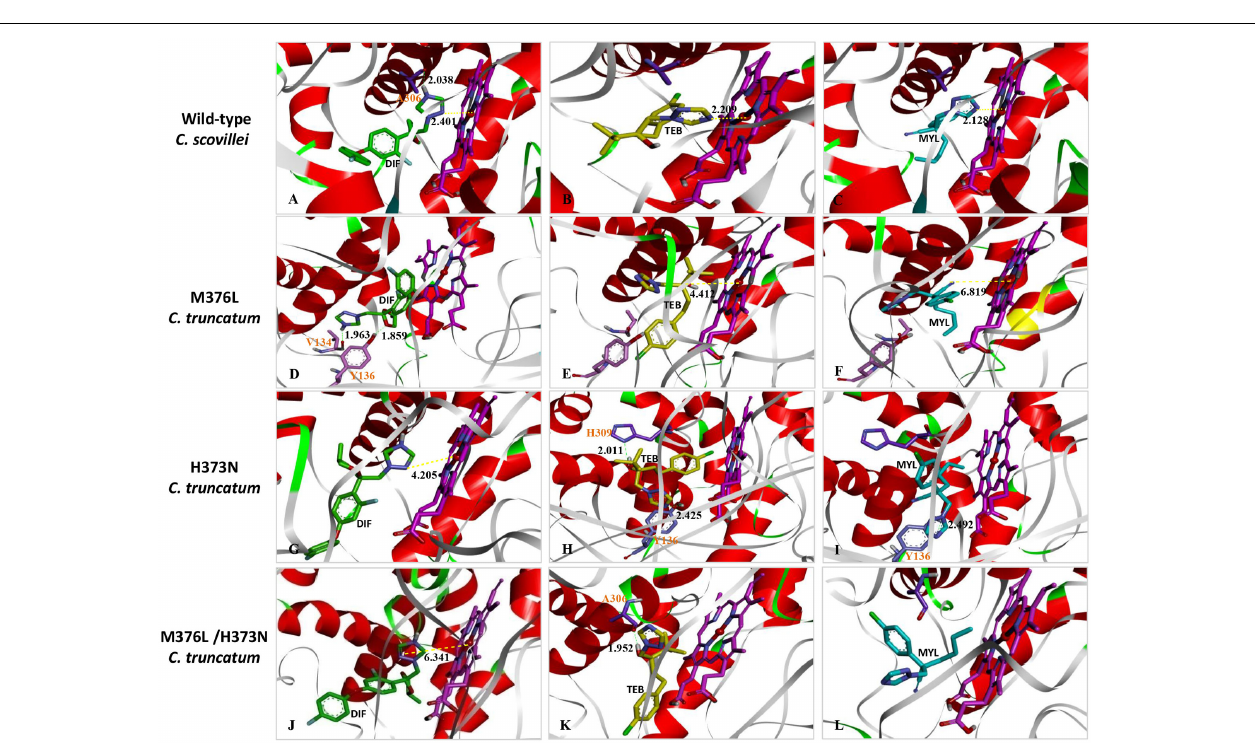
FIGURE 3 | Docking of DMI fungicides in the modeled binding pockets of CYP51 in C. scovillei and C. truncatum . The CYP51 models have mutations M376L, H373N, or M376L and H373N. The fungicides are difenoconazole (DIF, green), tebuconazole (TEB, yellow), and myclobutanil (MYL, cyan). The structure of C. scovillei was modeled with the template of 5EAB from Saccharomyces cerevisiae by the On-line Swiss-model software. The structure of C. truncatum CYP51 was modeled by mutations at residues M376 (M376L), H373 (H373N), or both M376 and H373 (M376L/H373N) based on the modeling of C. scovillei , and the Tripos force field with Gasteiger-Marsili charges was used for the energy minimization. (A–C) Represent the binding pockets of the three DMI fungicides in the CYP51 of C. scovillei ; (D–L) represent the binding pockets of the three DMI fungicides in the CYP51 of C. truncatum with different mutations ( D–F : M376L, G-I: H373N, J-L: M376L /H373N). The yellow dash indicates the Fe – N coordinate bond between the heme iron active site and oxygen heterocyclic ring of the DMI fungicide. The green dash represents the hydrogen bond between the amino acid and the